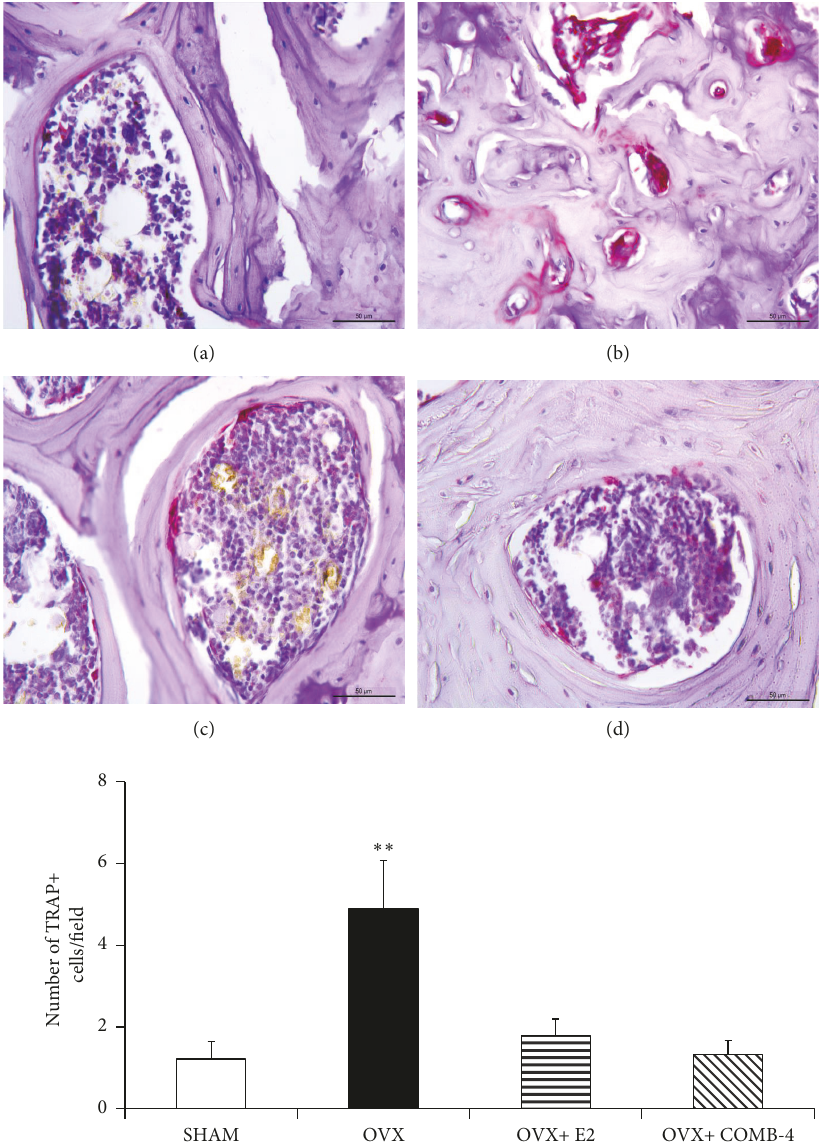
Figure 6: Tartrate acid phosphatase (TRAP) staining in lumbar vertebrae. Five 𝜇 m paraffin embedded sections of L4-5 vertebrae were stained with prewarmed TRAP staining solution, containing Fast Red Violet LB Salt and Naphthol AS-MX Phosphate Substrate . Top Panel: representative images of positive trap cells in (a): SHAM, (b): OVX, (c): OVX+E2, and (d): OVX+COMB-4 after 100 days treatment. TRAP+ cells are stained in pink/violet. Sections were counterstained with hematoxylin to observe the cell nuclei. Magnification 400X; Bar: 50 um. Bottom Panel: number of TRAP-positive staining cells per field. ∗∗ p < 0.05 respect to SHAM, OVX+E2, OVX+COMB-4. n = 8 per